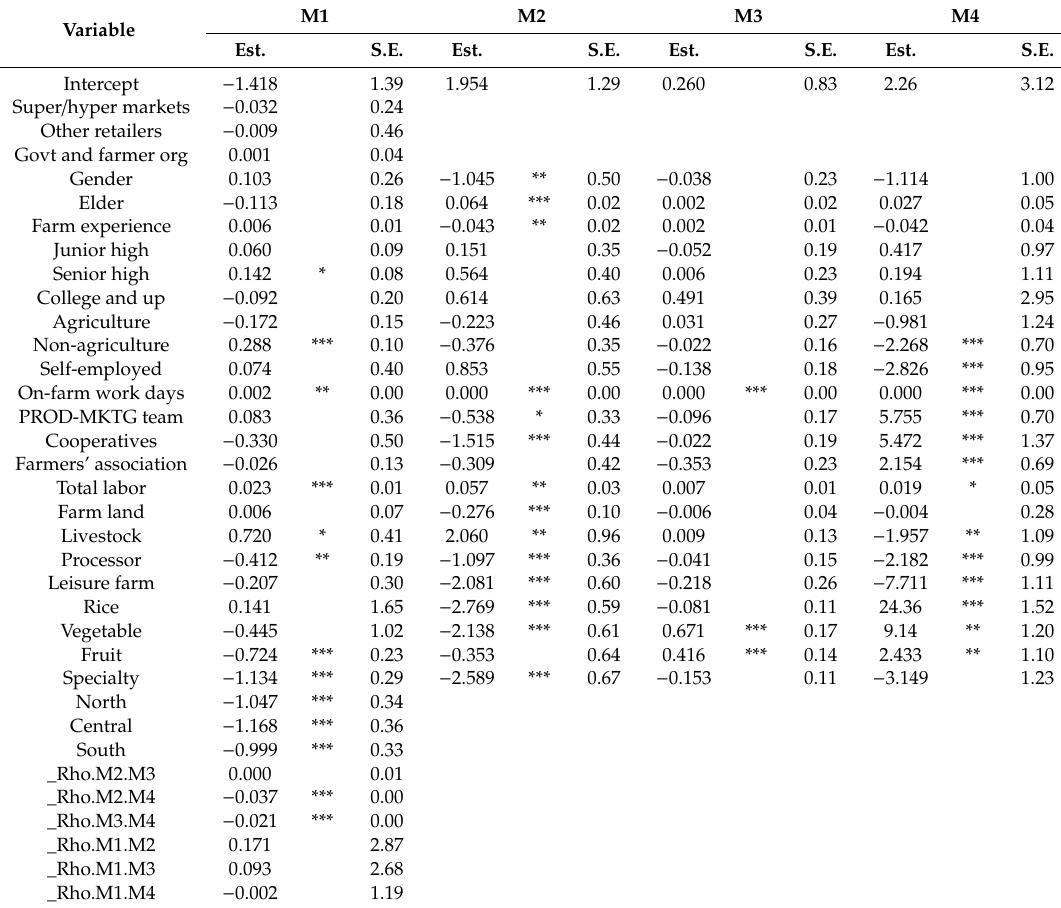
Table 2. Full information maximum likelihood (FIML) estimates of contracting farming and the three marketing